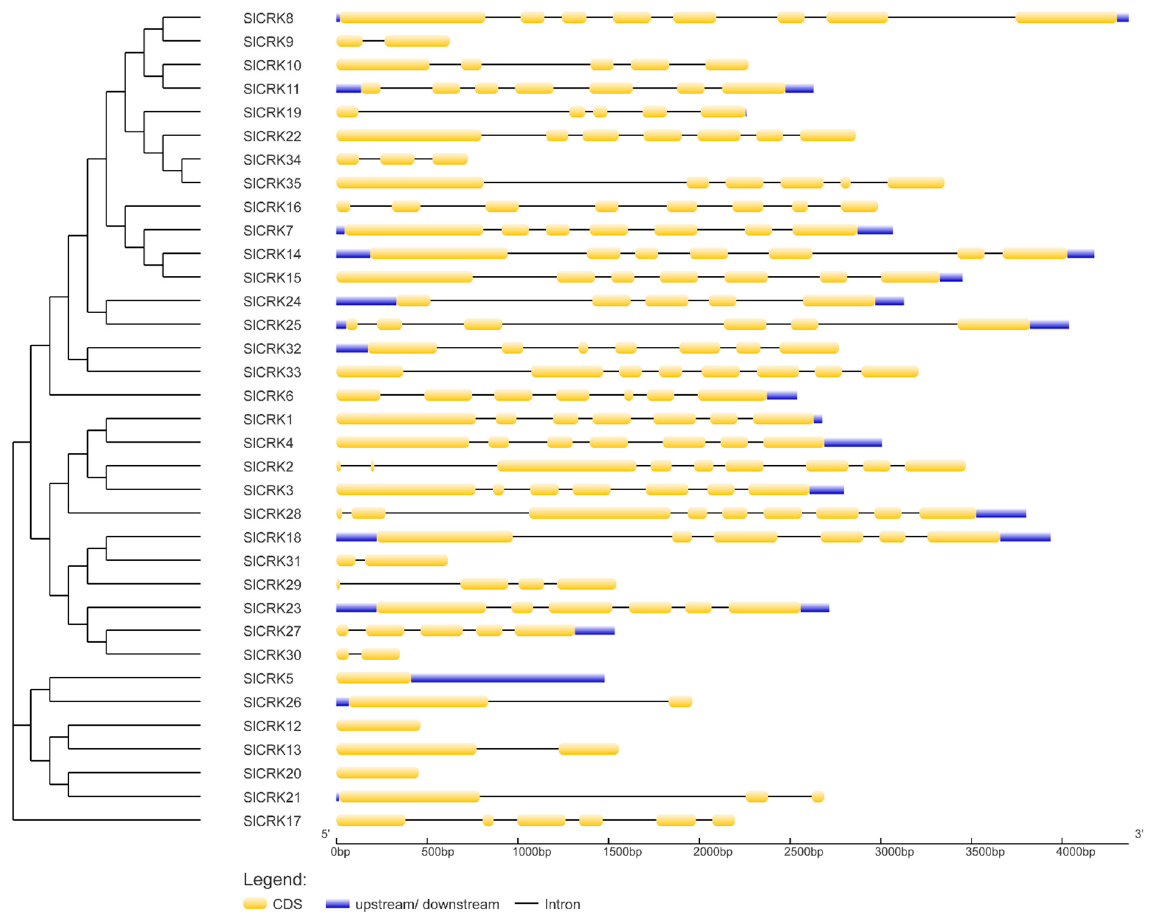
Figure 4. Gene structure analysis of SlCRK genes. Yellow boxes, blue boxes and lines indicate exons; untranslated regions indicate introns.